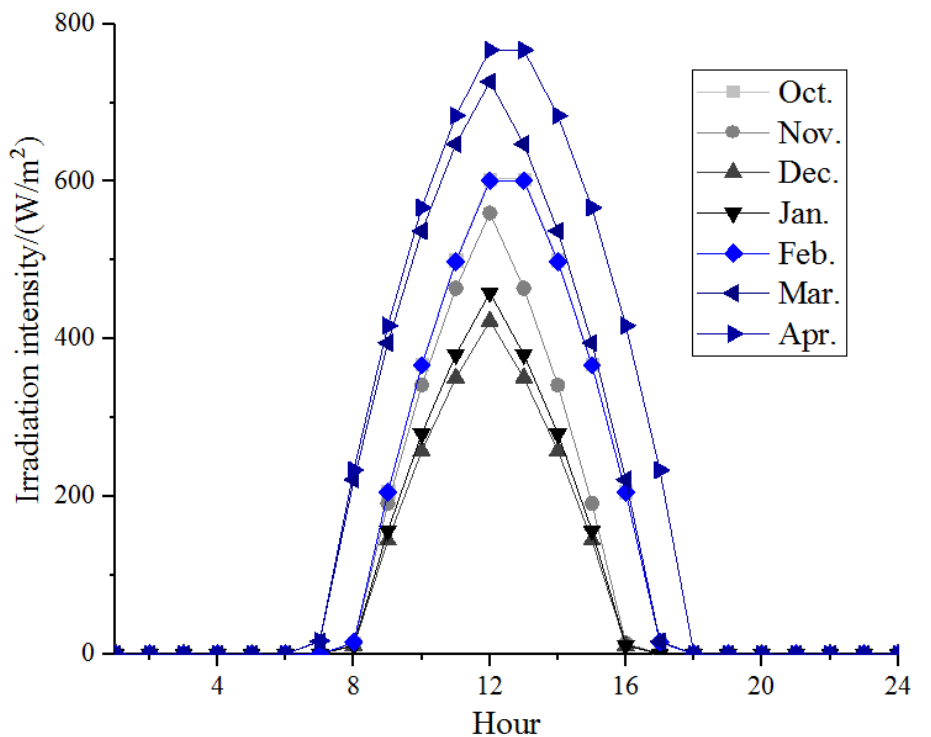
Figure 2. Meteorological parameters in the Chifeng city of China.